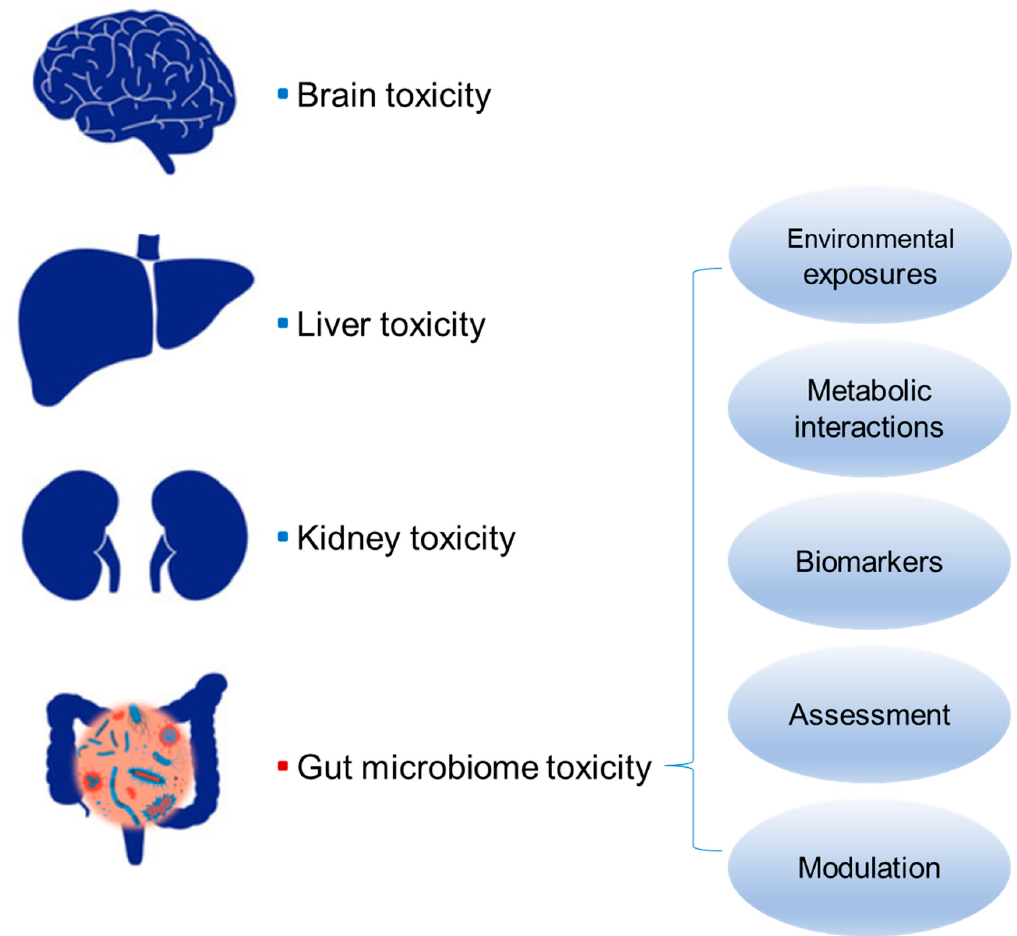
Figure 1. A potential new member of the organ toxicity family: gut microbiome toxicity. Toxicity of organs including brain, liver, and kidney is well defined and acknowledged. Similarly, the discussion of gut microbiome toxicity encompasses environmental exposures (causes), interactions between the gut microbiome toxicity and human diseases (mechanisms of gut microbiota-related diseases), biomarker and assessment (diagnosis), and modulation (treatment).